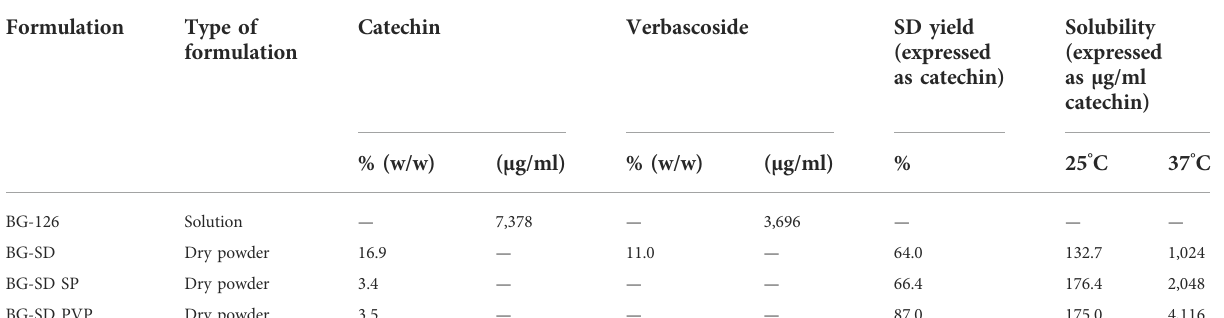
TABLE 2 Characterization of BG